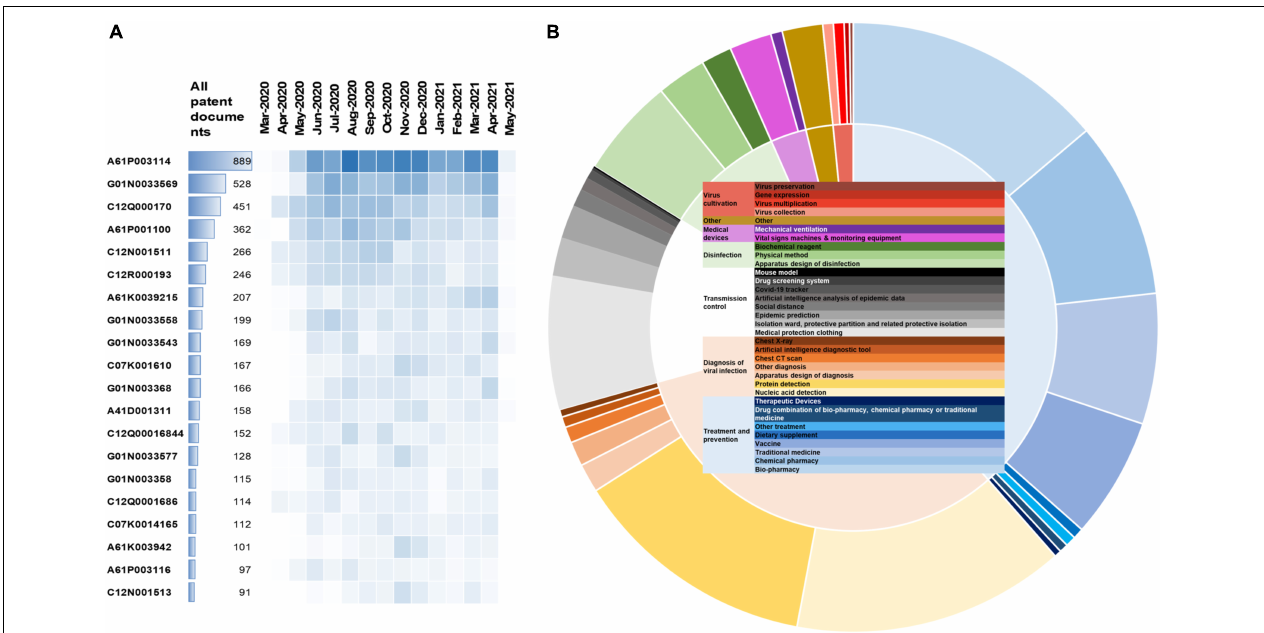
FIGURE 3 | Distribution of the types of functional classification of COVID-19 patents. (A) The temporal evolution of the leading 20 International Patent Classification (IPC) codes. (B) Sunburst chart by focused functions. The area of the graph represents the percentage of